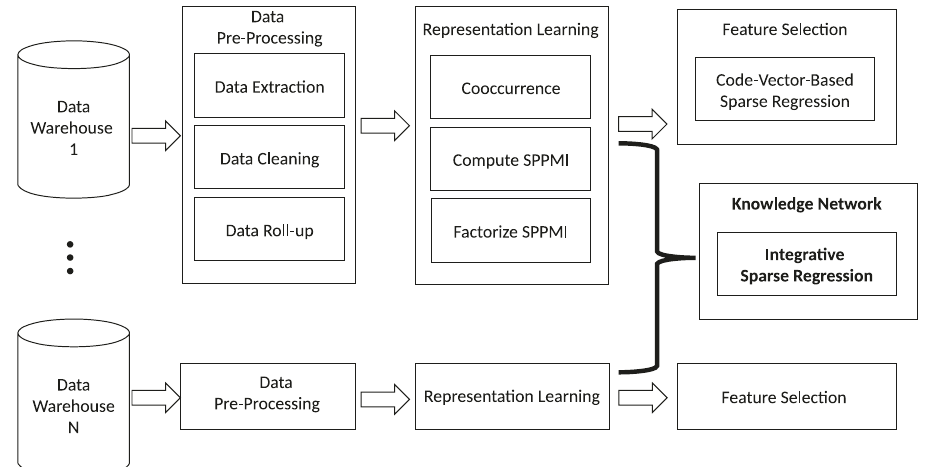
Fig. 1 Overview of KESER procedure. The KESER procedure includes four steps: ( i ) data pre-processing; ( ii ) representation learning using co- occurrence data and pointwise mutual information; ( iii ) feature selection at a single site; ( iv ) building a knowledge network across multiple